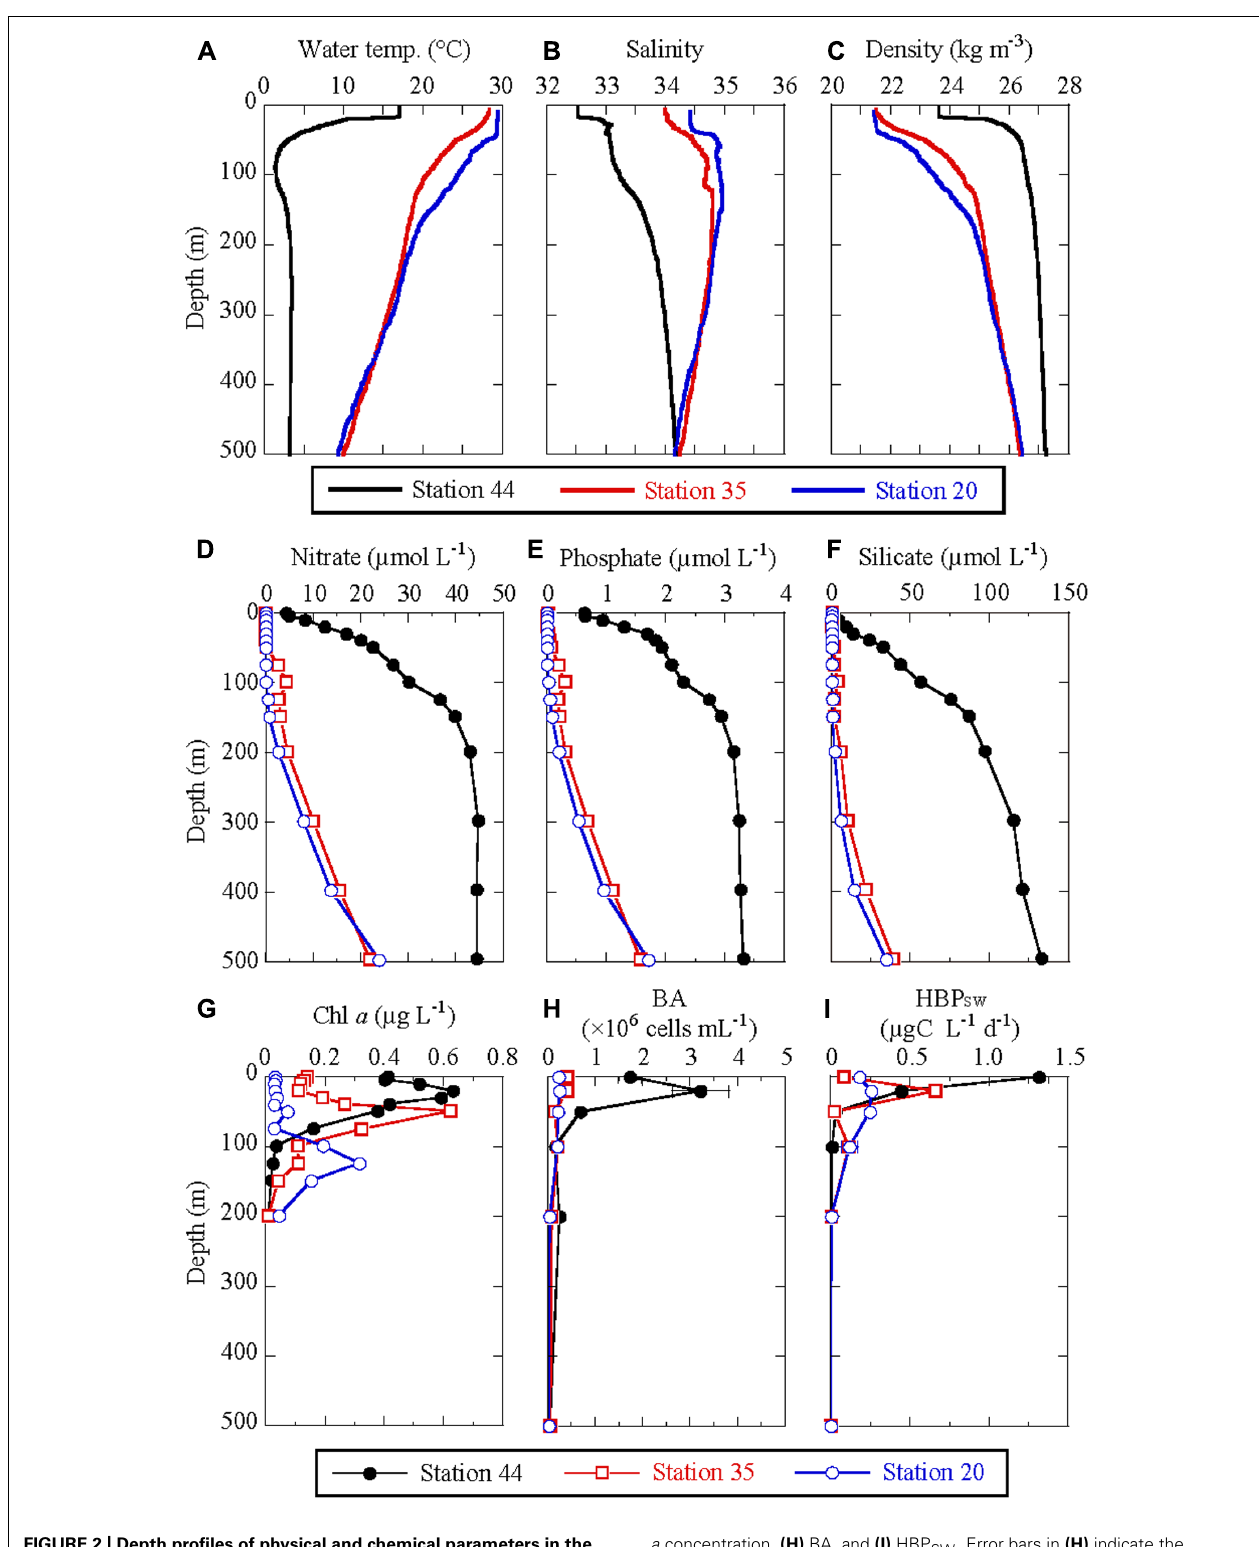
FIGURE 2 | Depth profiles of physical and chemical parameters in the water column at three stations in the western North Pacific Ocean. (A) water temperature, (B) salinity, (C) density (sigma-t), (D) nitrate concentration, (E) phosphate concentration, (F) silicate concentration, (G) Chl